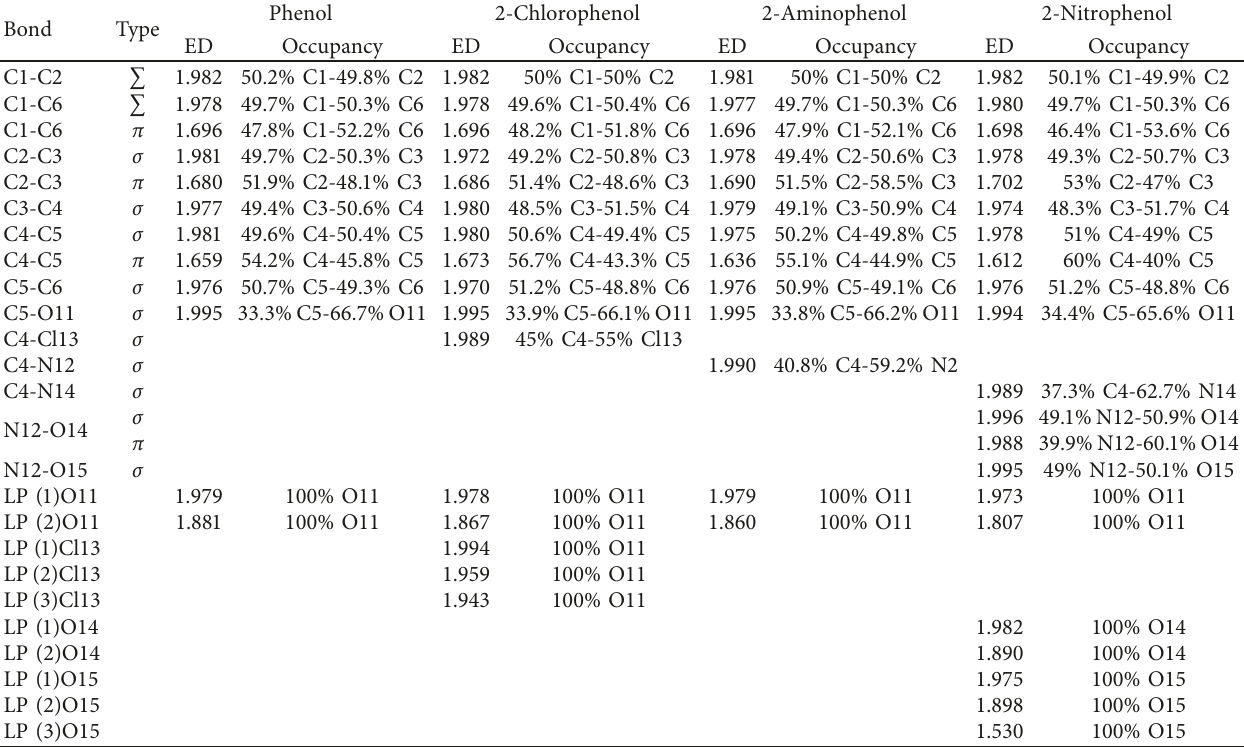
Table 4: NBO population analyses for the respective compounds.